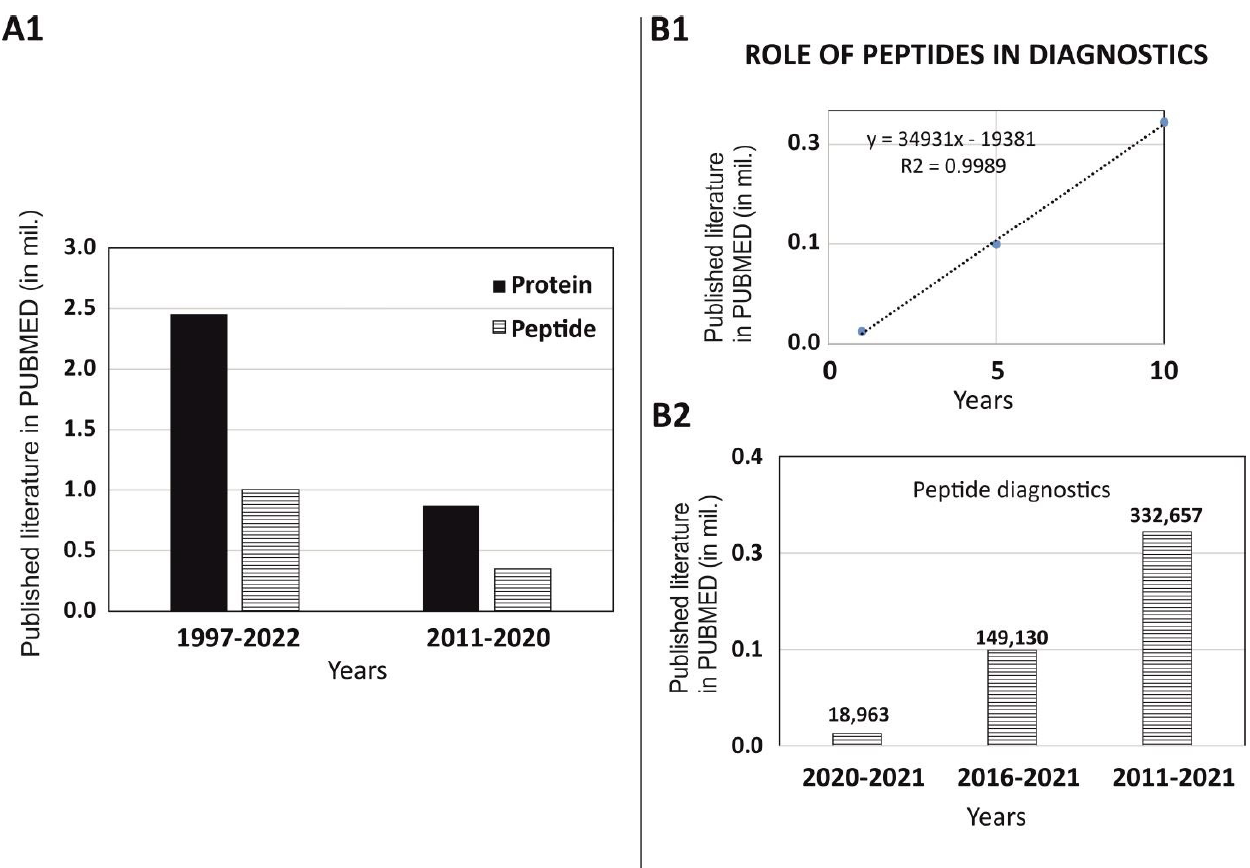
Figure 1. Role of peptides in diagnostics based on scientific research published on PUBMED : ( A1 ) comparison of the published data of diagnostics using protein versus peptides-( B1 , B2 ) exploring the role of peptides in diagnostics (1year, 5years, and 10years).